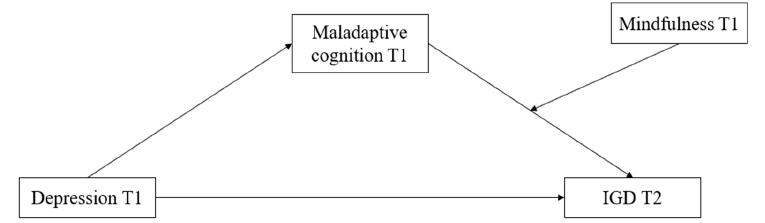
Figure 1. Moderated Mediation Hypothesis Model. Note. IGD = Internet Gaming Disorder; T1 = at Wave 1; T2 = at Wave 2. N =